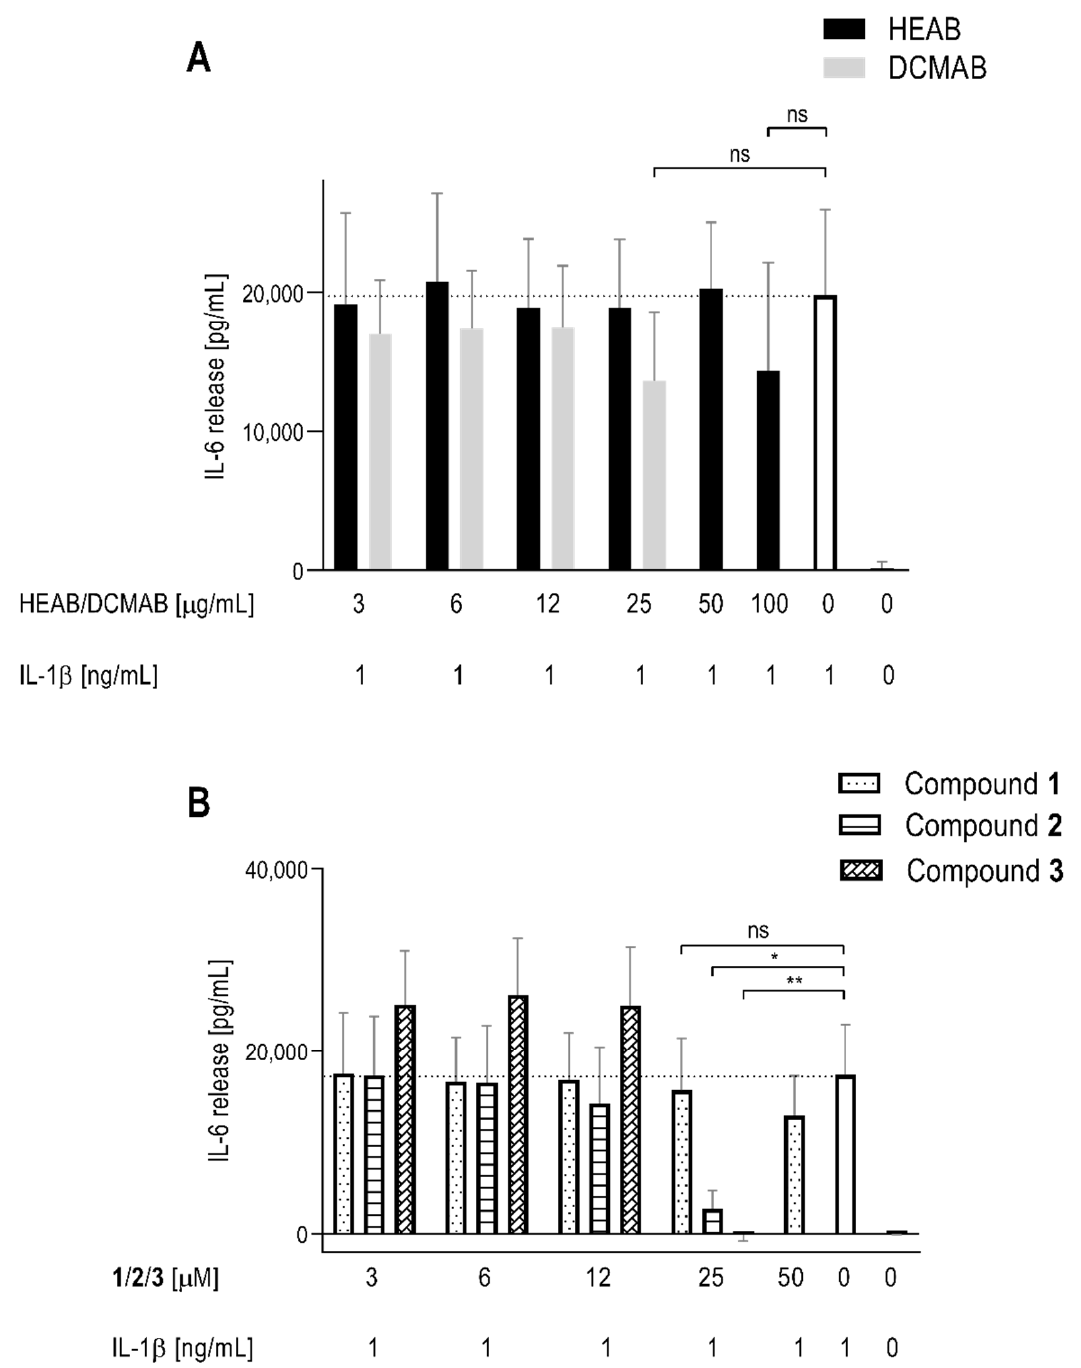
Figure 4. Release of pro-inflammatory cytokine IL-6 from IL-1 β activated HFLS incubated with root extracts ( A ) and isolated compounds 1 – 3 ( B ), after 24 h. Bars correspond to mean values ± S.D.; n = 6. * p < 0.05, ** p < 0.009 and ns = no significance. Dotted lines represent cut-off of maximum IL-6 release by Il-1 β stimulation.